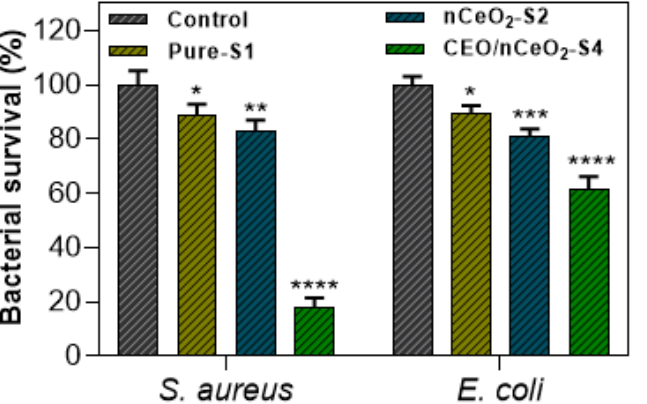
Figure 6. Antibacterial activity (Log CFU/mL) of Pure-S1, nCeO 2 -S1, CEO/nCeO 2 -S3, and CEO/nCeO 2 -S4, against S. aureus and E. coli . Data are expressed as average ± SD. * p < 0.0332; ** p < 0.0021, *** p < 0.0002, **** p < 0.0001, versus control.